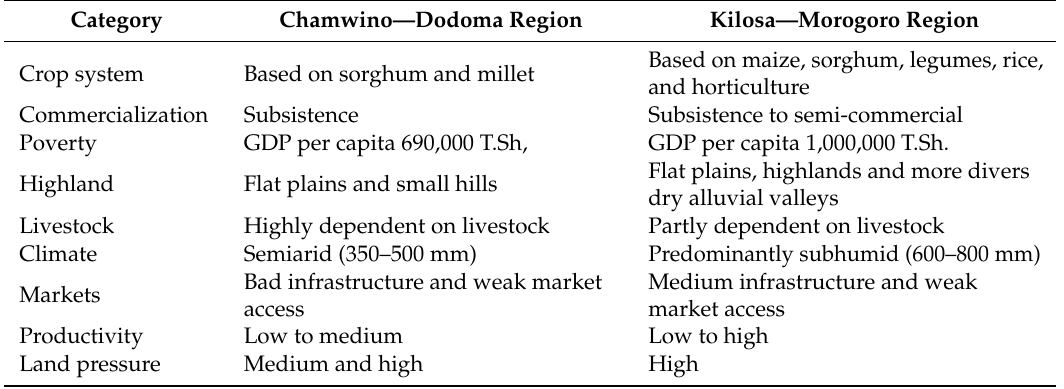
Table A1. Basic characteristics of the two sample sites.